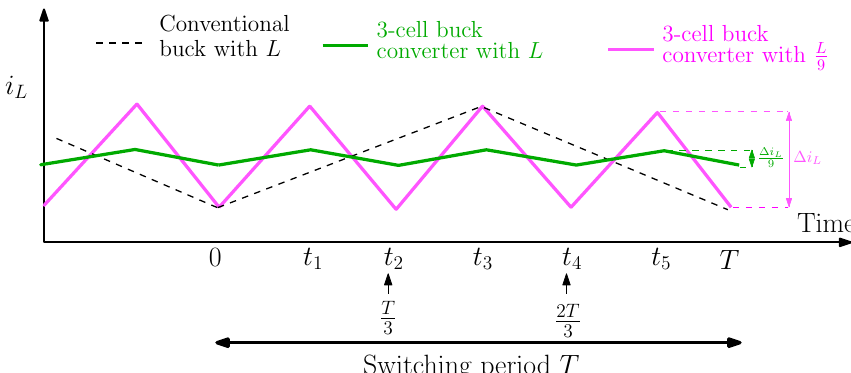
Figure 2. Inductor current waveforms for the conventional buck converter with a switching period T and inductance L and two different inductor choice for the 3-cell buck converter operating at the same switching